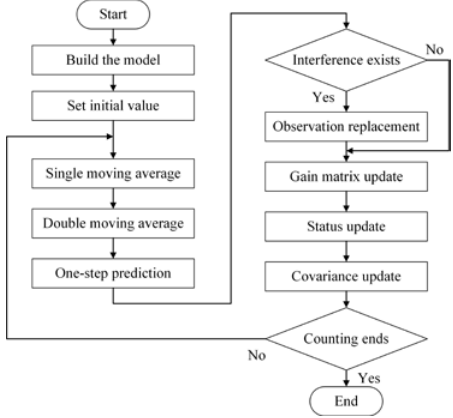
Fig. 3. Flow chart of the improved algorithm.